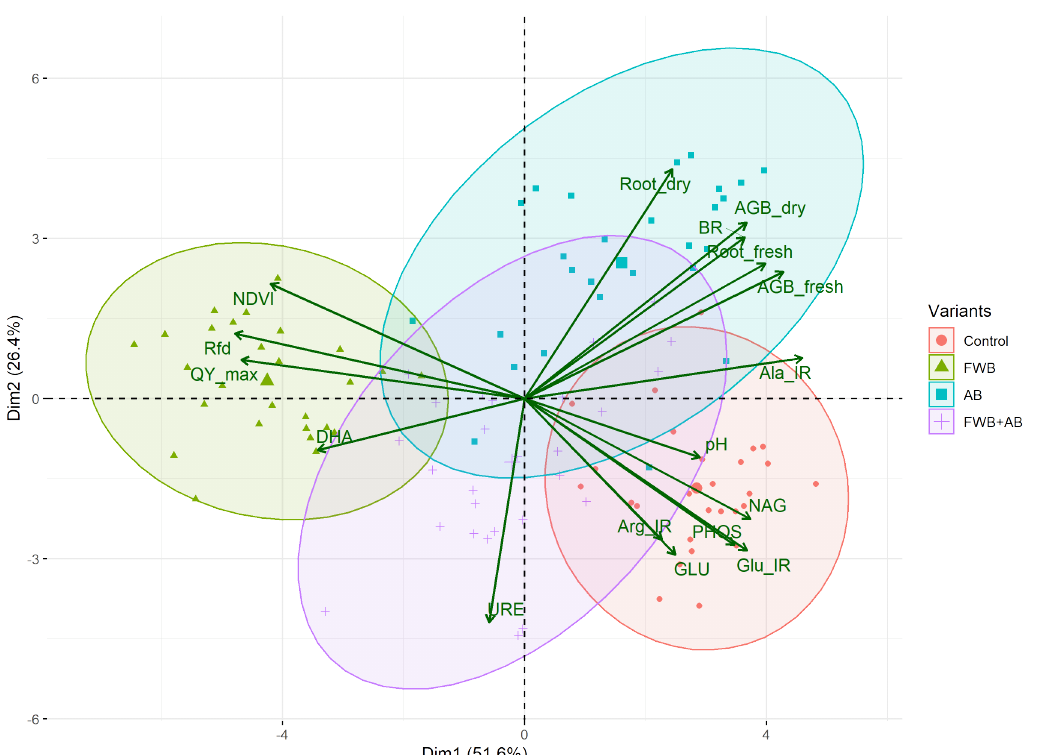
Figure 5. Principal component analysis of the observed parameters and applied amendments. Ab- Figure 5. Principalcomponent analysisof theobservedparameters andapplied amendments.